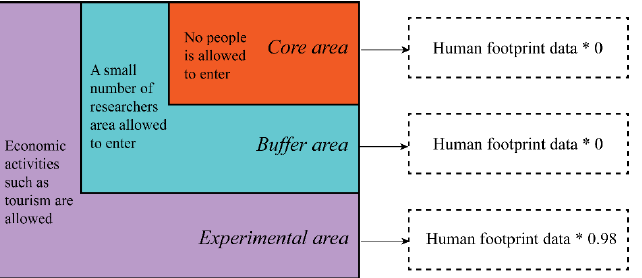
Figure 2. Description of the valuation method of nature reserves. (* in the figure represent ×.)